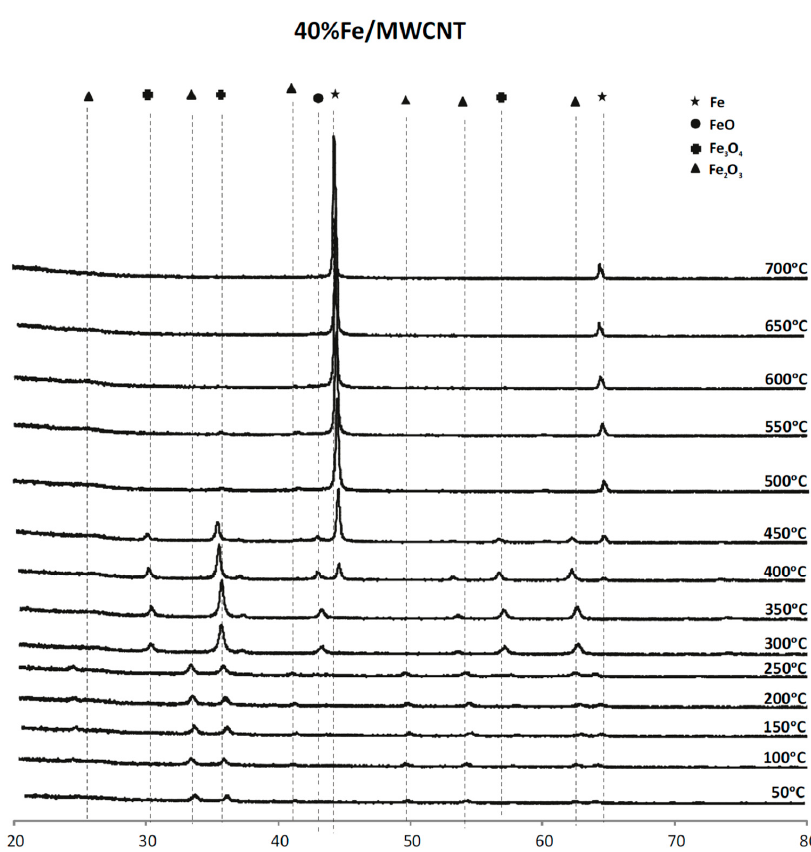
Figure 5. The X-ray diffraction patterns of the Fe/multi-walled carbon nanotube (MWCNT)